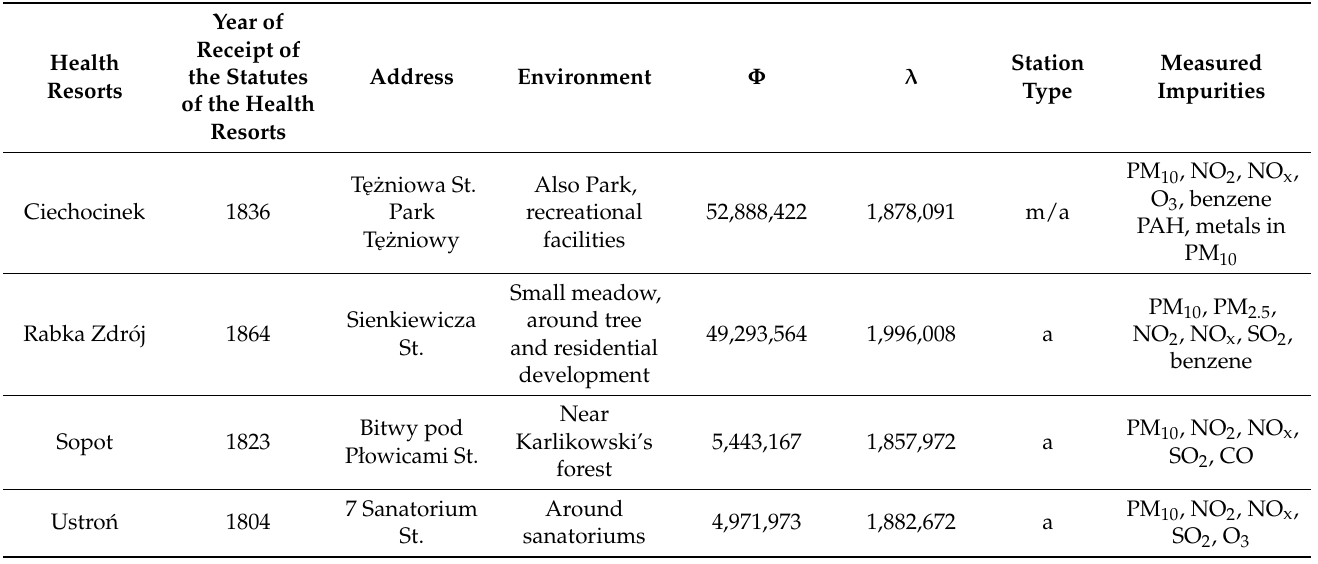
Table 1. Basic characteristics of the analyzed pollution monitoring stations in selected health resorts.